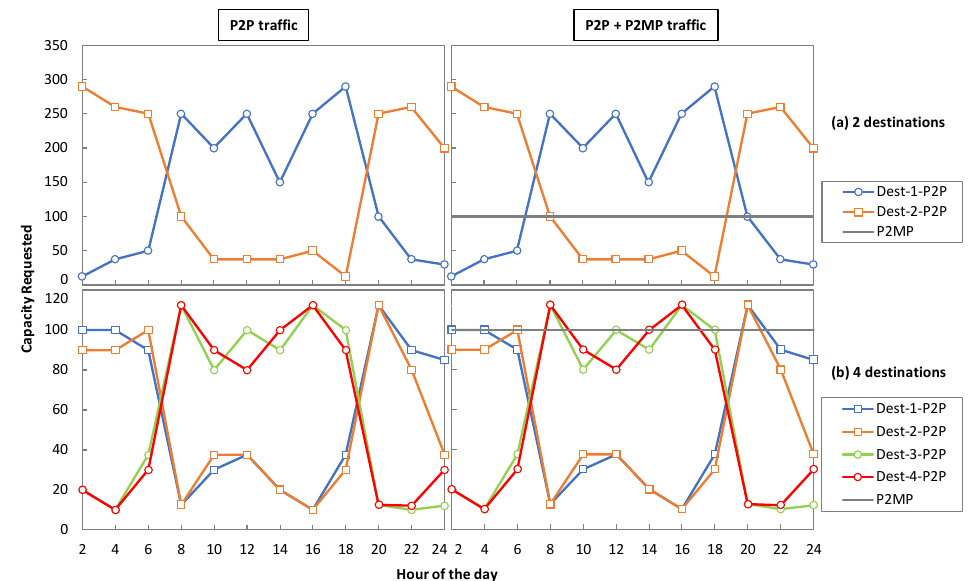
Figure 9. Traffic profiles for P2P and P2P + P2MP traffic with 2 and 4 destinations. Considering the same traffic profile and transceivers’ availability as described previously, Figure 10 represents savings in terms of the number of transceivers required for OCS and DSCM as compared to the P2P lightpath solution. For the P2P traffic scenario, both OCS and DSCM provide equal savings in both aggressive and non-aggressive availabilities. For 2 destinations, the reduction in transceivers is 25%, whereas for 4 destinations, it is 38%. However, for the P2P + P2MP traffic scenario, we observe a different trend. In the aggressive availability, OCS and DSCM provide the same savings, i.e., 57% and 62% for 2 and 4 destinations, respectively. However, in non-aggressive availability, OCS outperforms DSCM, which provides 14% and 23% savings for 2 and 4 destinations, respectively, in comparison to 57% and 62% of OCS, i.e., 43% and 39% more savings, respectively. The reason behind these results is the additional number of transceivers required in DSCM to serve P2MP traffic when the highest data rate